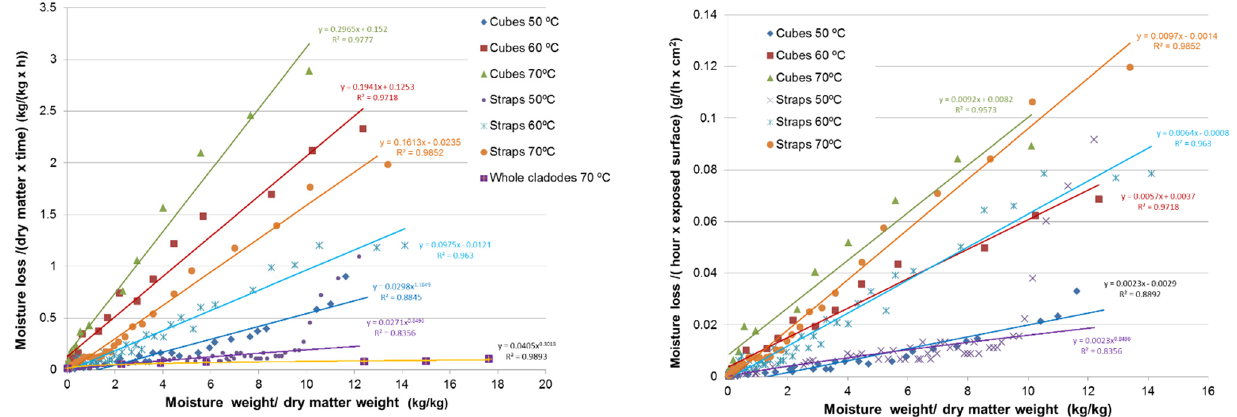
Figure 6. Drying rates ( left ) and drying rates per unit of exposed tissues surface ( right ) of prickly-pear cladodes cut into different geometries and dried at different temperatures.